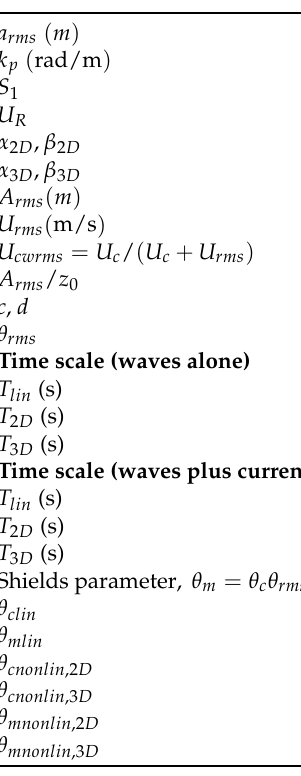
Table 1. Example calculation with h = 10 m, d 50 = 1 mm, D = 1 m, n =